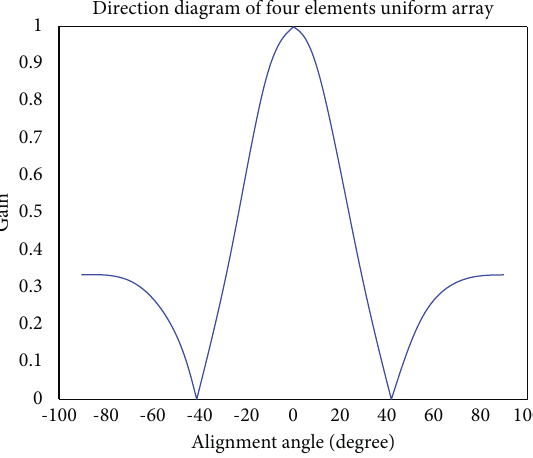
Figure 2: Directional diagram of a 4-element uniform linear array.